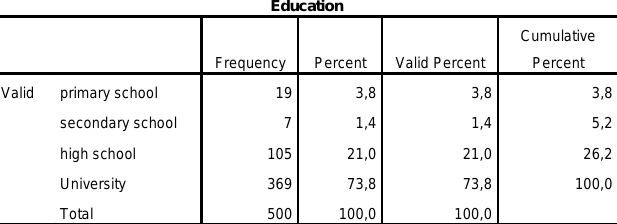
Table 3: Education